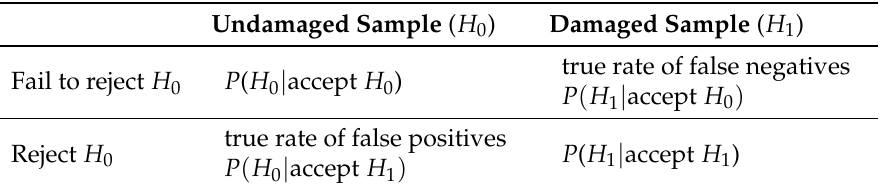
Table 9. Relationship between the proportion of false negatives and false